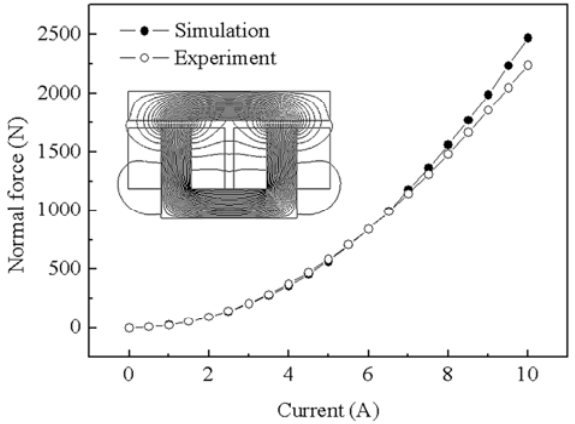
Figure 7. Comparison of FEM and experiment (reference model).